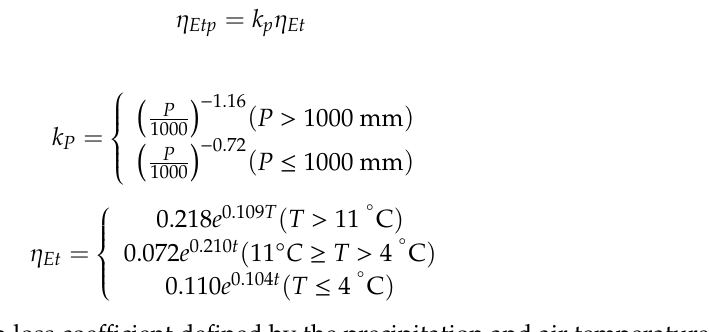
vs. I and the relationship curve of k I = f ( I ) I ′ vs. k I and the relationship curve of I